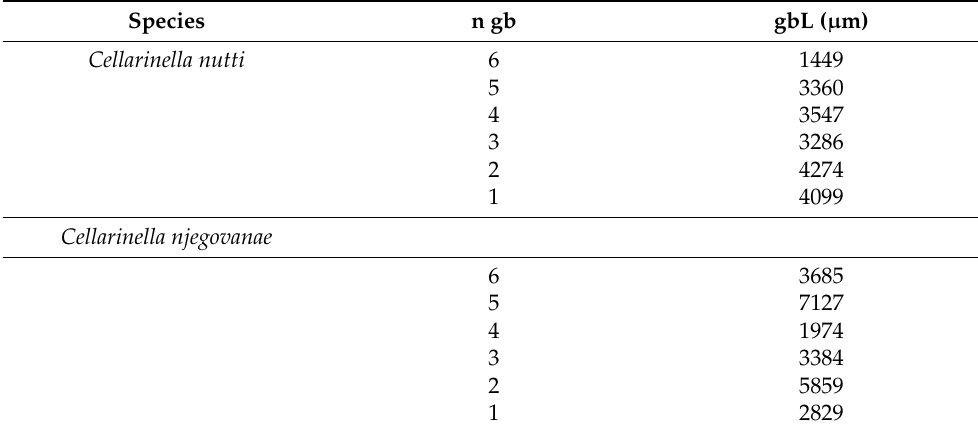
Table 2. Growth band number (n gb) and length (gbL) ( µ m) in Cellarinella nutti and Cellarinella njegovanae branches. Mean number of growth bands (n band) are reported per colony per species in a decreasing order, from the youngest (n 6) just below the growing edge, to the oldest part of the branch (n 1).